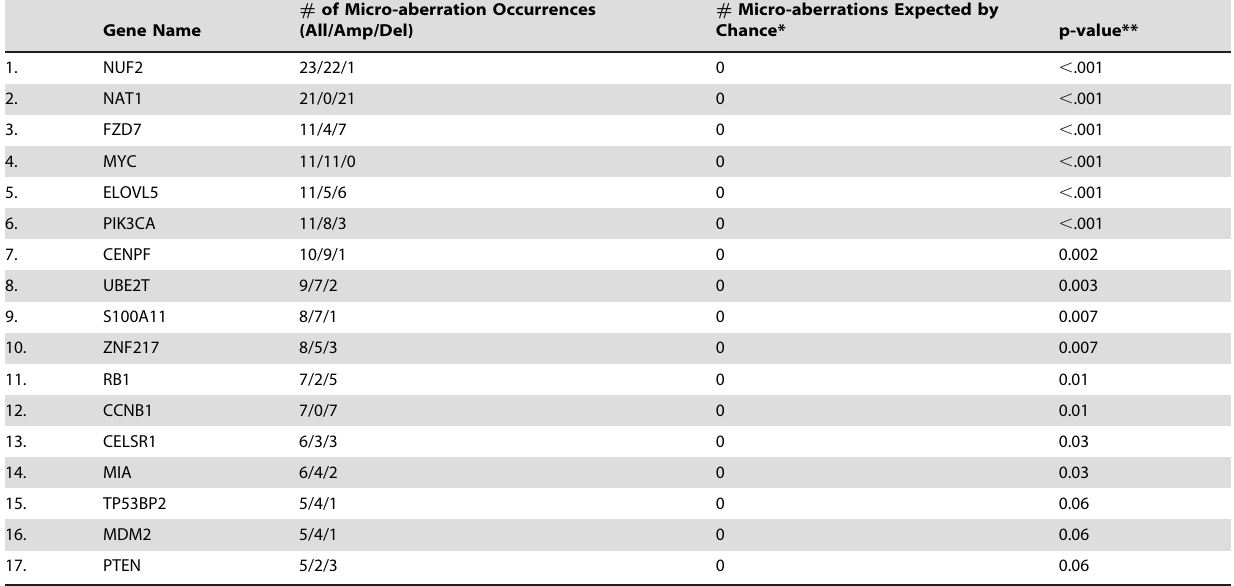
Table 4. Micro-aberration Frequency by